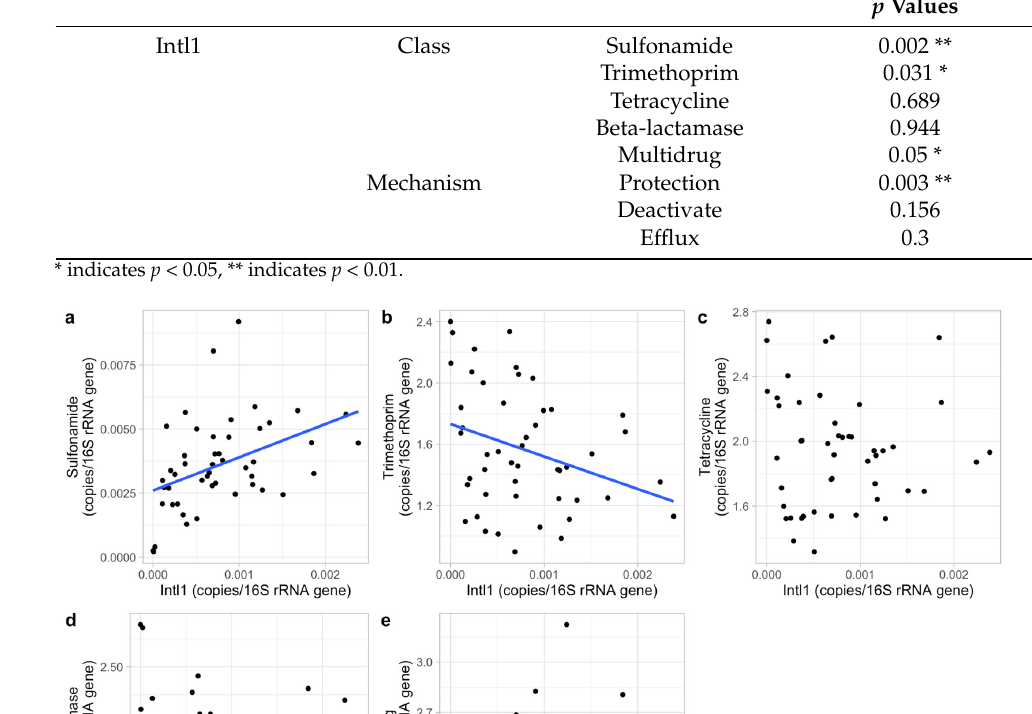
Table 3. P values of linear models of intl1 concentrations vs. the relative concentrations of ARGs summed up by antibiotic class and mechanism. The relative concentration of each class and mechanism was log 10 (x*10 6 ) transformed except for sulfonamide and protection to meet normal distributions. p Values Intl1 Class Sulfonamide 0.002 **